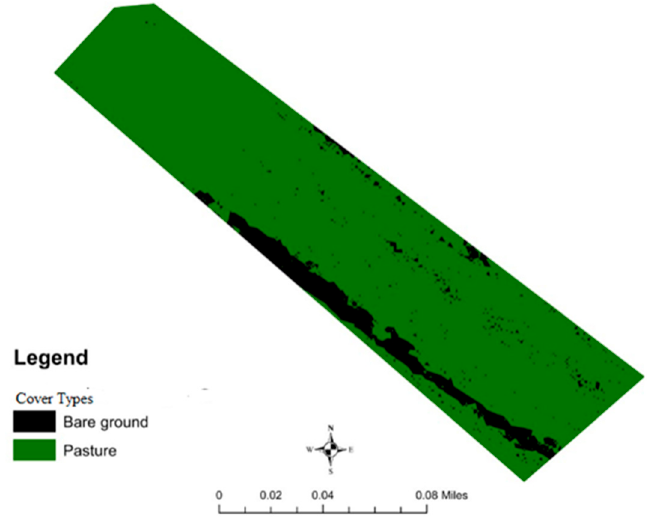
Figure 4. Pre-flooding grazing land cover.